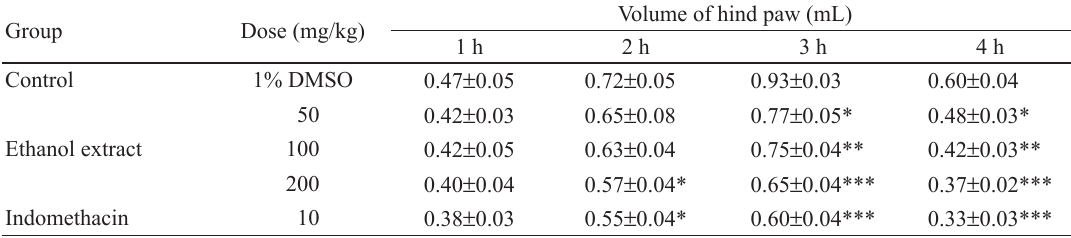
Indomethacin Data are mean ± S.E.M. of 6 rats. * p < 0.05; ** p < 0.01; *** p < 0.001 vs control group. The experimental groups were pre-treated 60 minutes previously to the beginning of